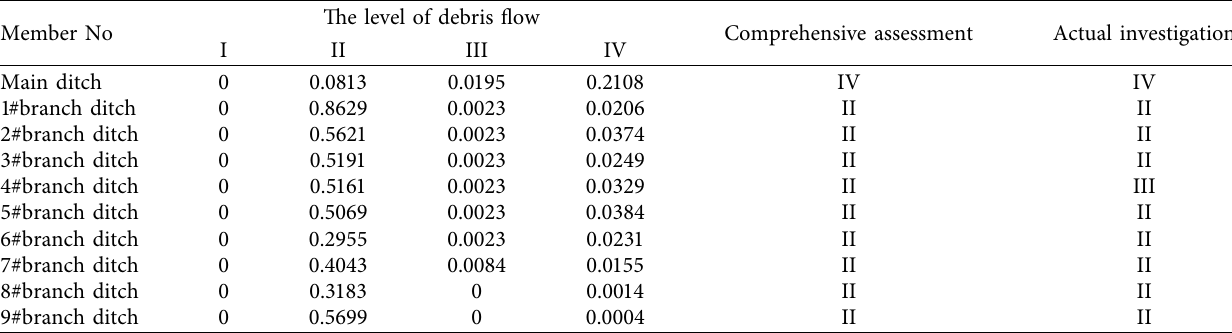
Figure 7: Cloud of each assessment index generated by the forward cloud generator. (a) The length of replenishment section X . (c) The gradient of side slope X . (d) The length of ditch X Longitudinal slope of main ditch X 2 3 drainage area X . (f) Rainfall X 6 Table 7: Comprehensive certainty degree.